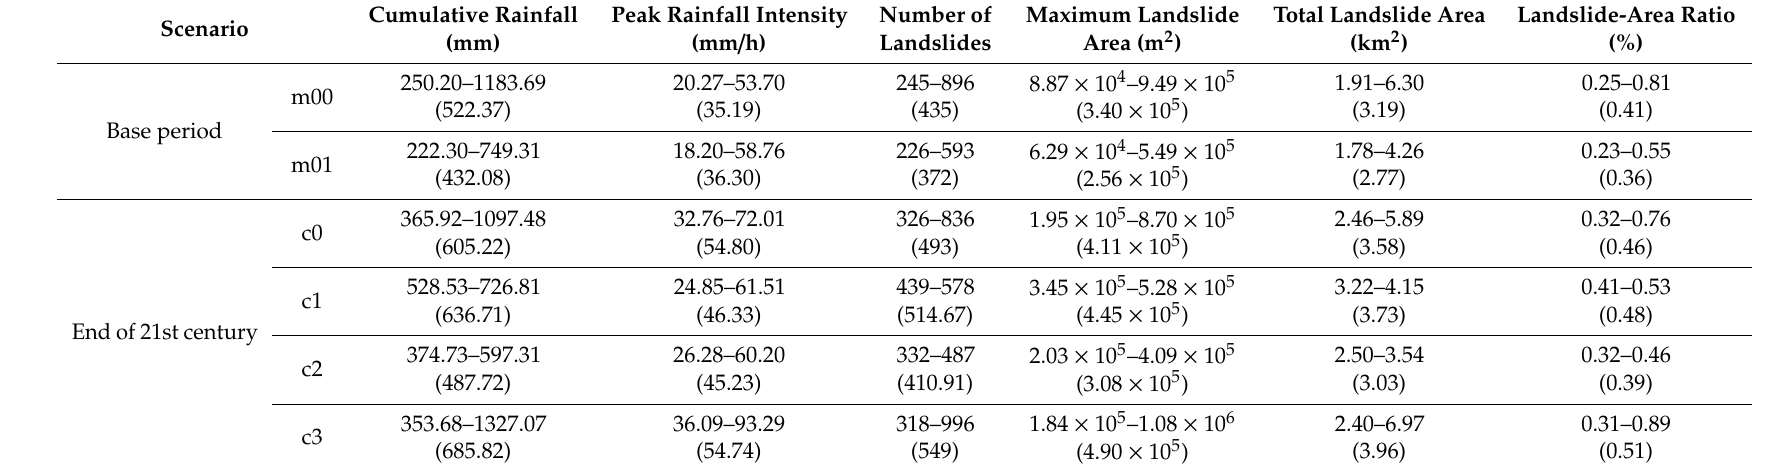
Table 2. The range of average rainfall conditions and possible landslide characteristics in the Shihmen Reservoir catchment during top 15% typhoon events. “()” is the average value of a